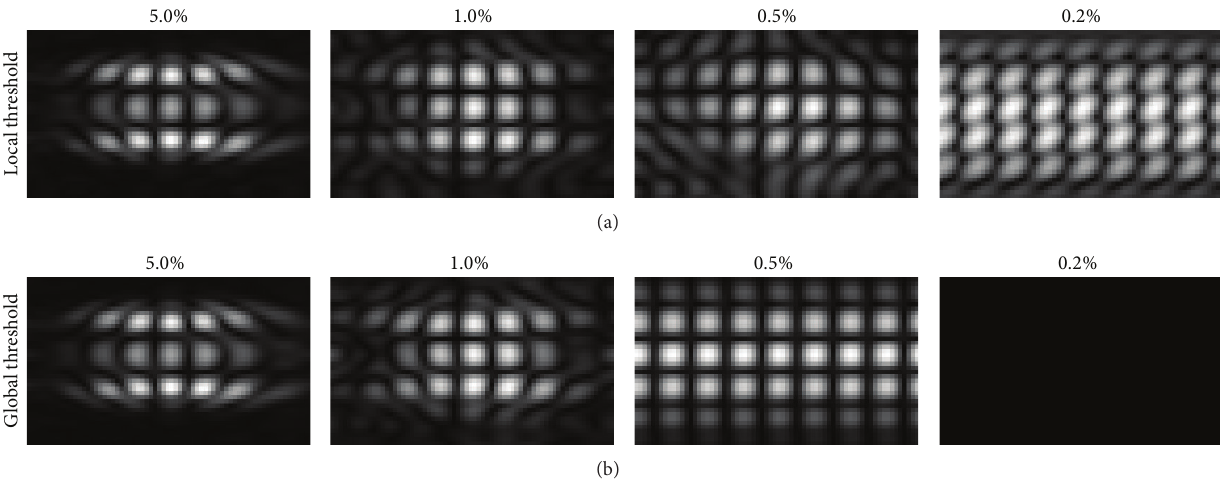
Figure 4: The 156th matrix row (about 123 kHz) of receive channel 𝑥 after applying a local (a) and a global (b) threshold for different compression rates between 0.2% and 5%. Note that, for 0.2% compression rate, no coefficients are above the threshold for the global thresholding